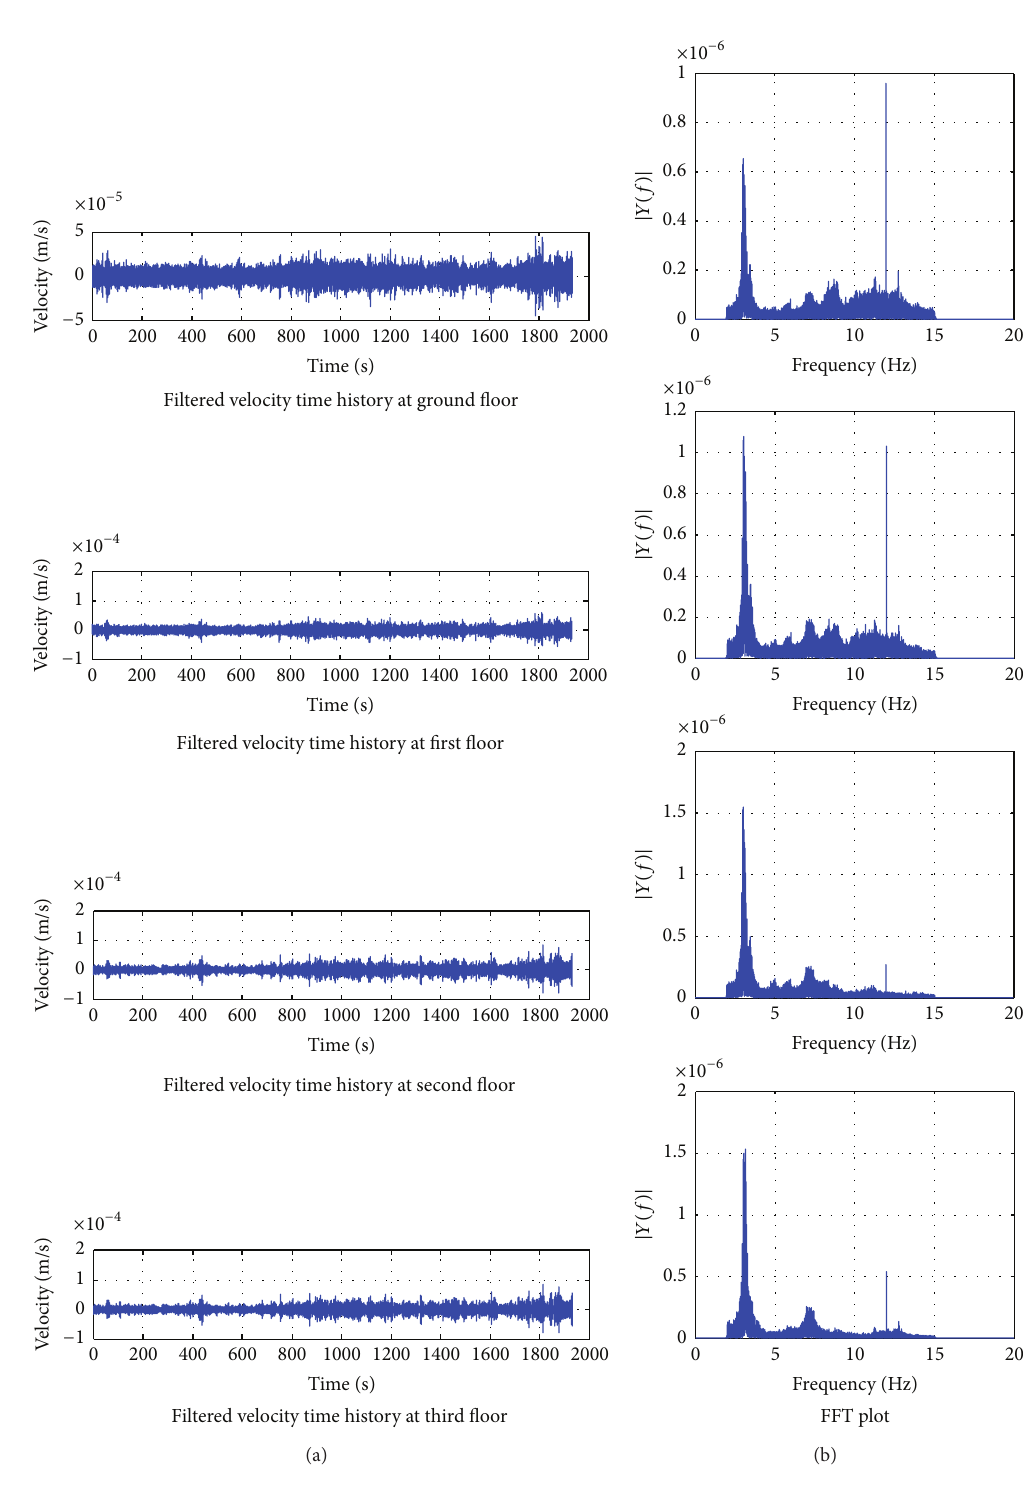
Figure 11: (a) Filtered velocity time histories at each floor in E-W direction and (b) their fast Fourier transformation (FFT) plots.